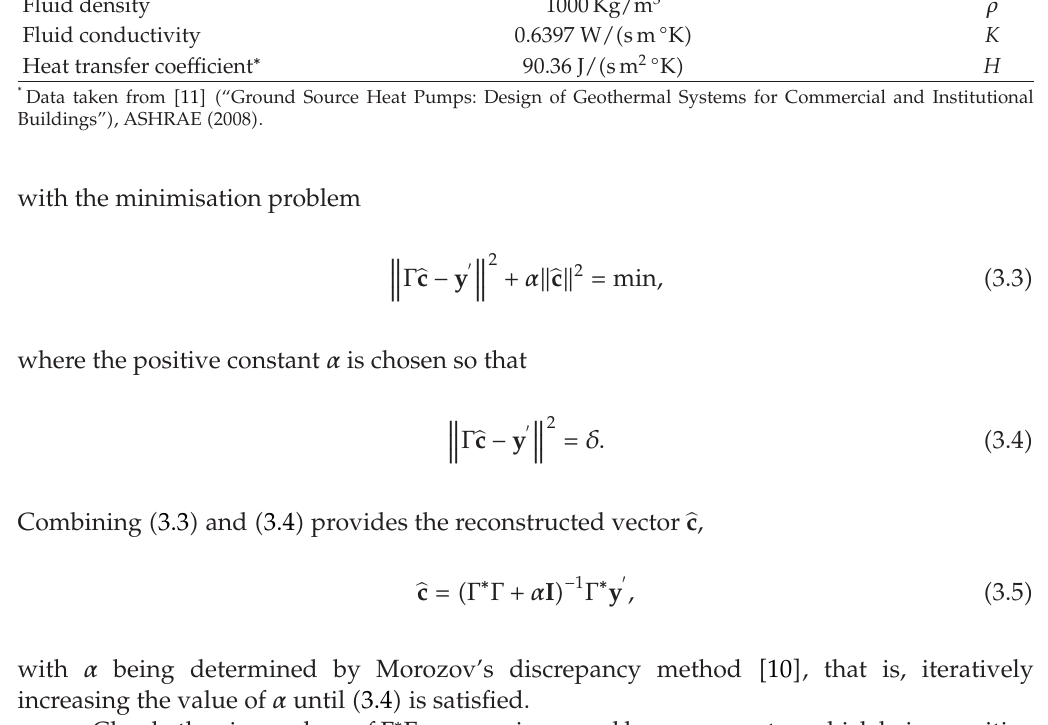
Parameter Value Symbol Fluid